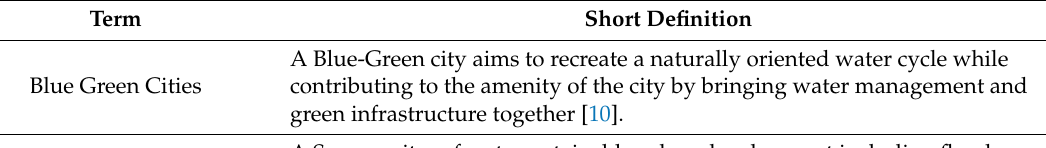
Table 1. Comparison of terms commonly used in different geographic regions. Term Short